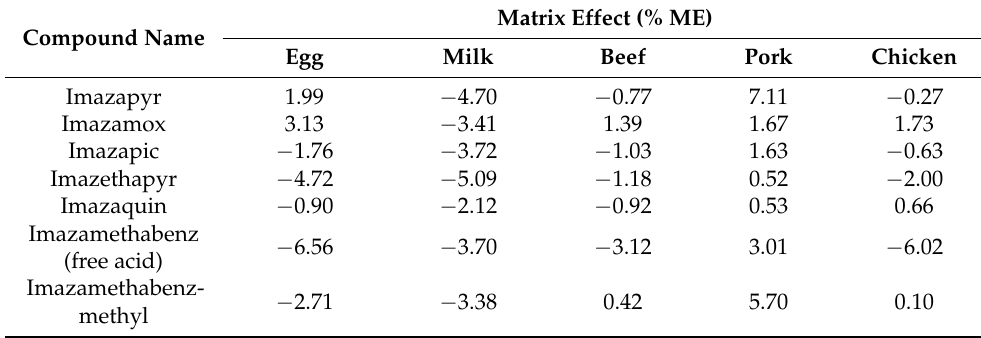
Table 4. Matrix effects for imidazolinone herbicides to livestock products.